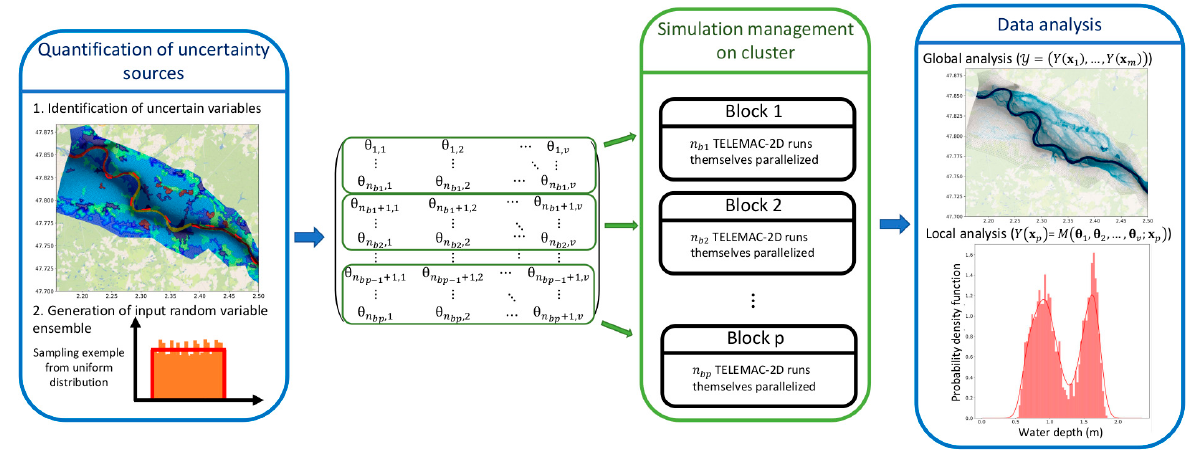
Figure 3. Overview of Monte Carlo framework.